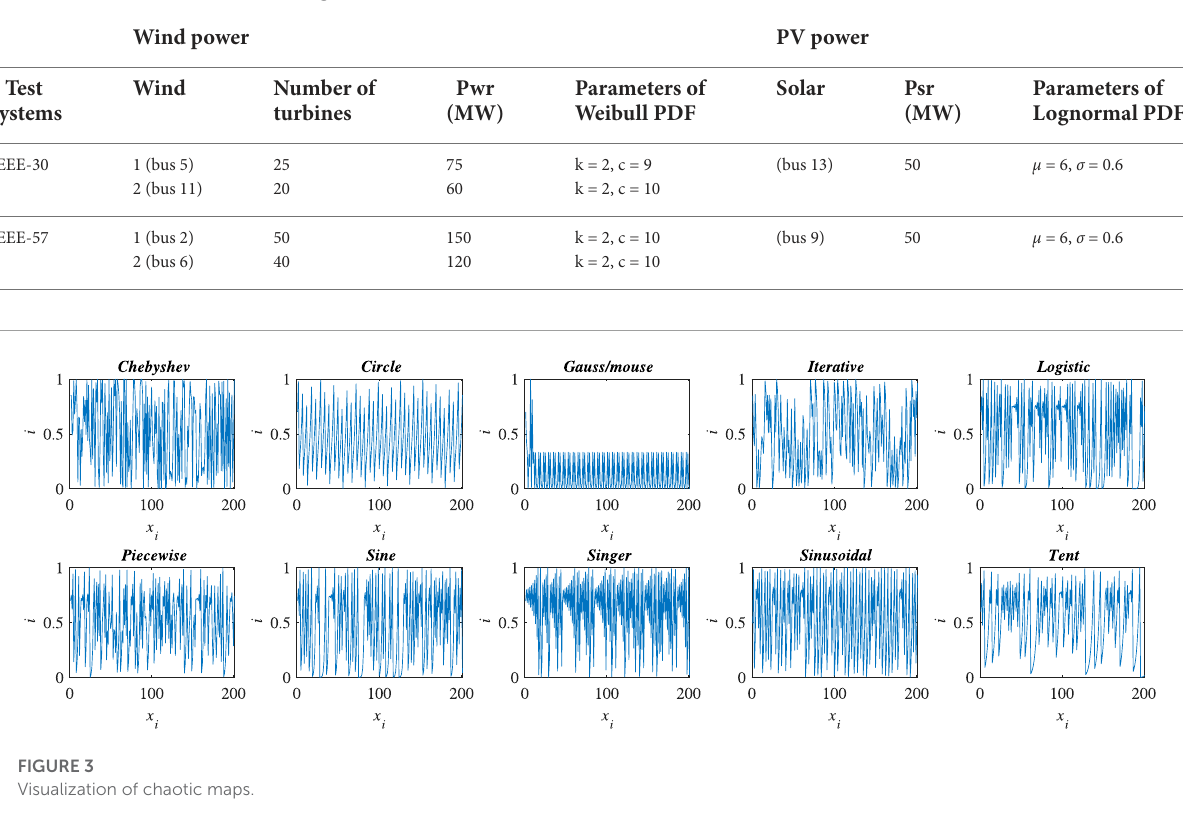
FIGURE 3 Visualization of chaotic